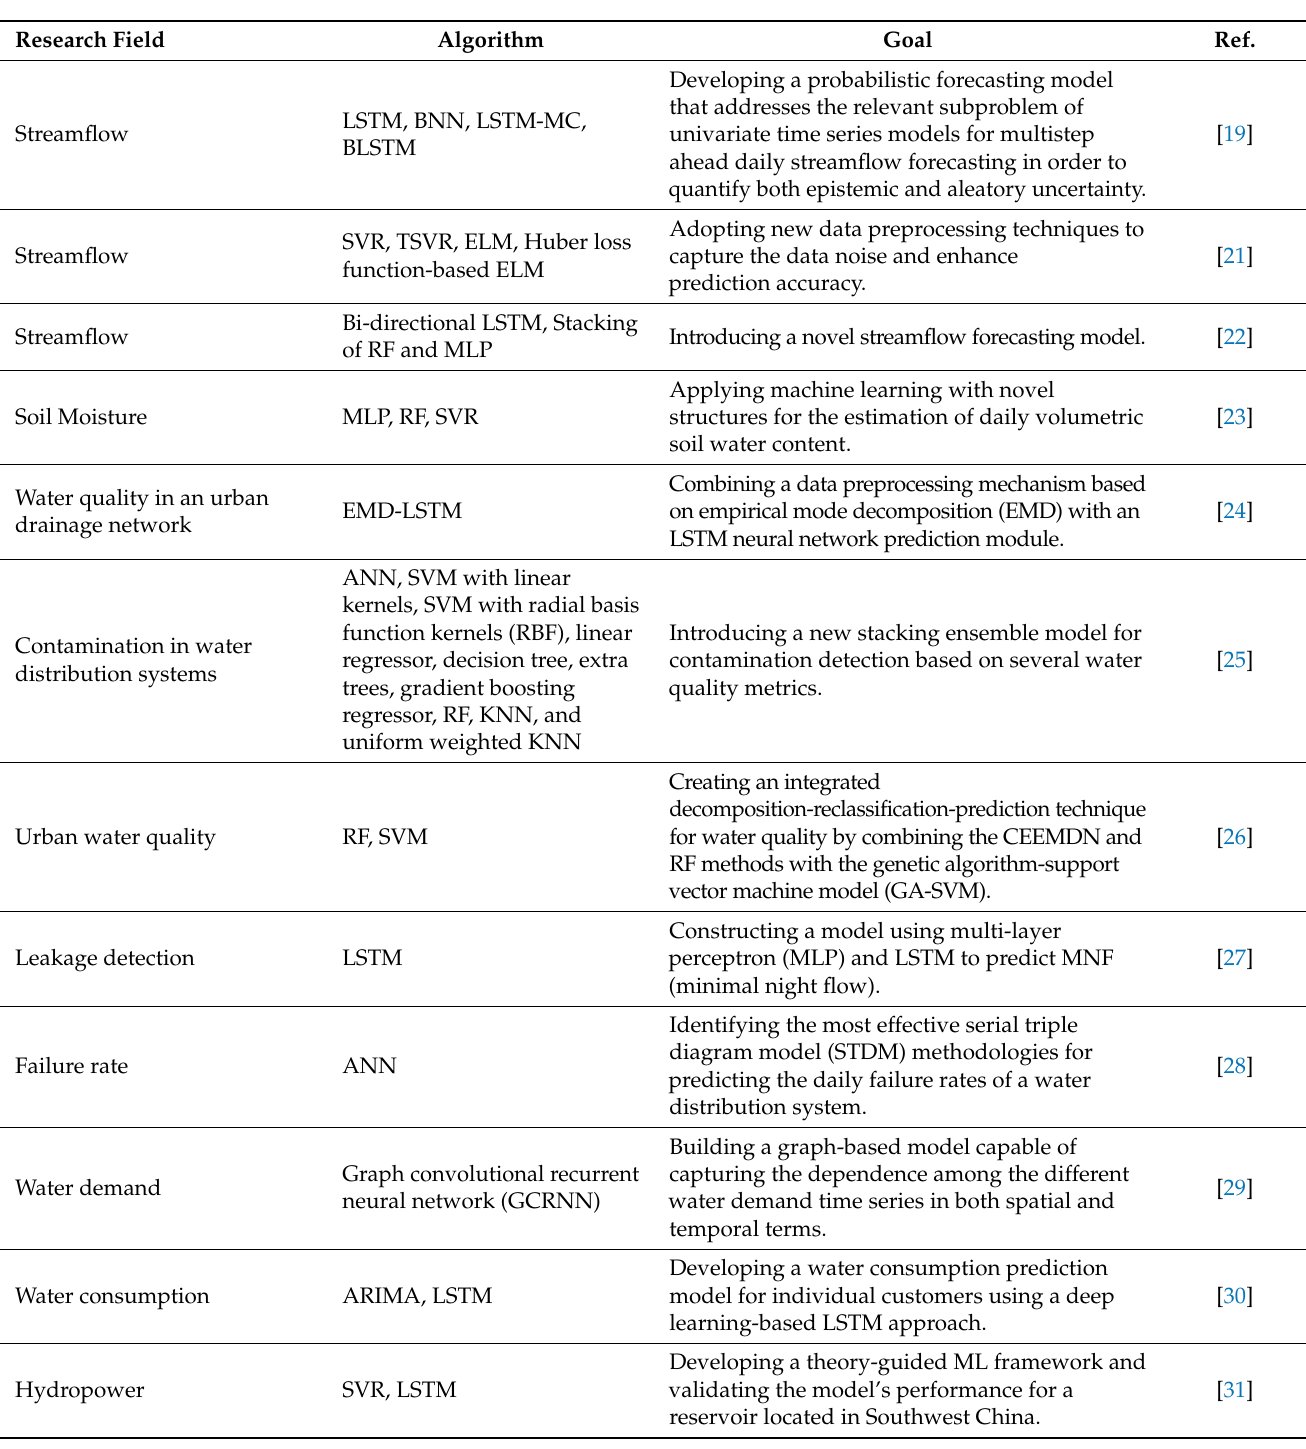
Table 4. Recent applications of ML for prediction in